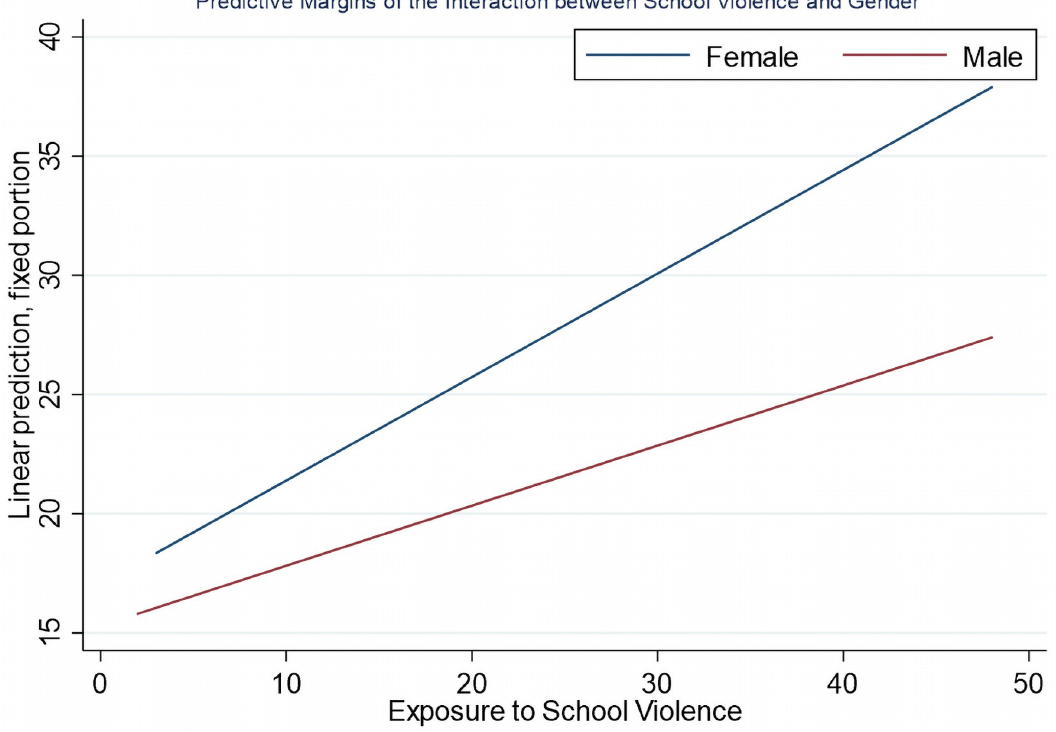
Fig 2. Gender as a moderator between exposure to school violence and internalising